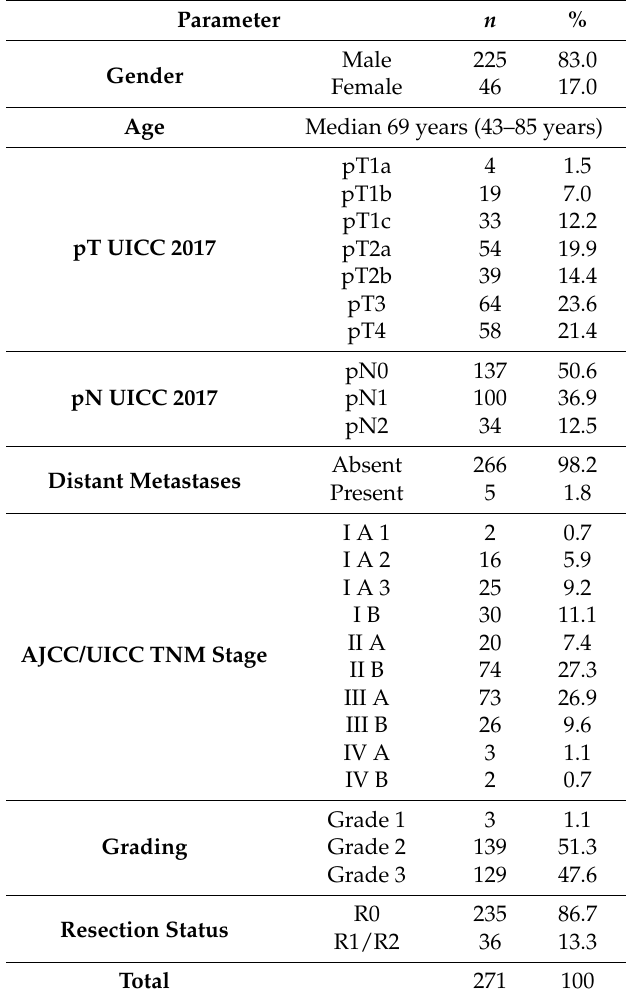
Table 3. Description of the case